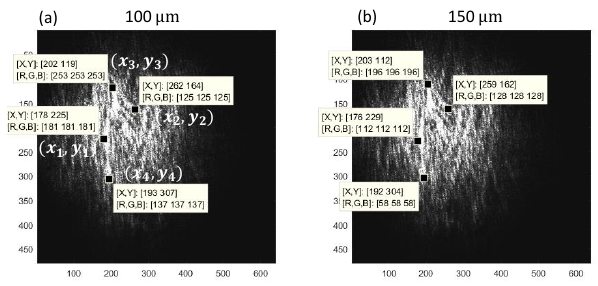
Figure 6. Four reference points used for visual estimation of